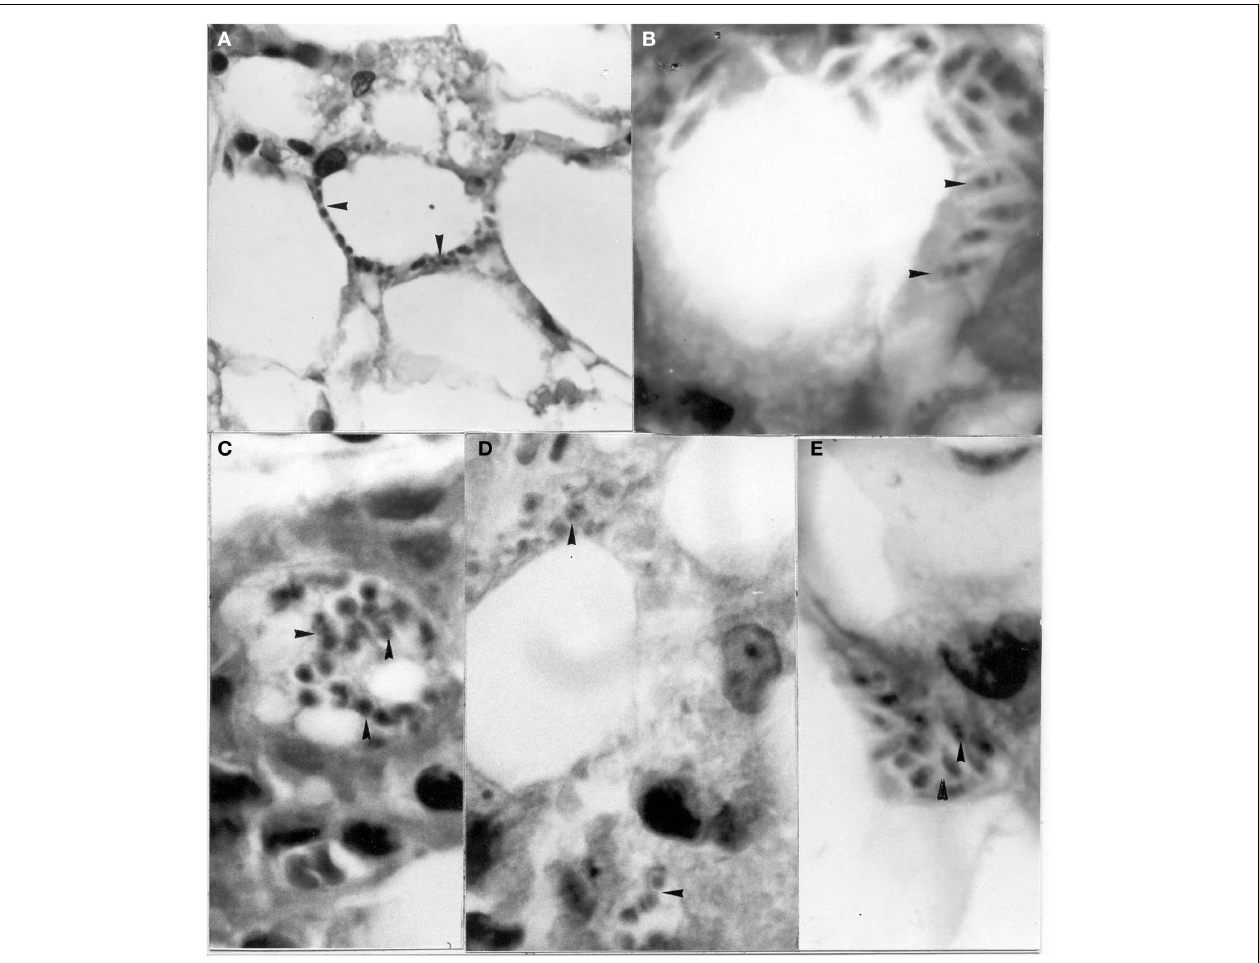
FIGURE 5 |Amastigotes and intermediate stages (arrows) of Trypanosoma cruzi in (A,B) perifery cytoplasm of an adipocye ; (C) cytoplasm of immature adipocite (preadipocite); (D) intercellular substance in connective adipose tissue; (E) parasitized macrophage located between uninfected adipocytes (H-E; 1400 ×